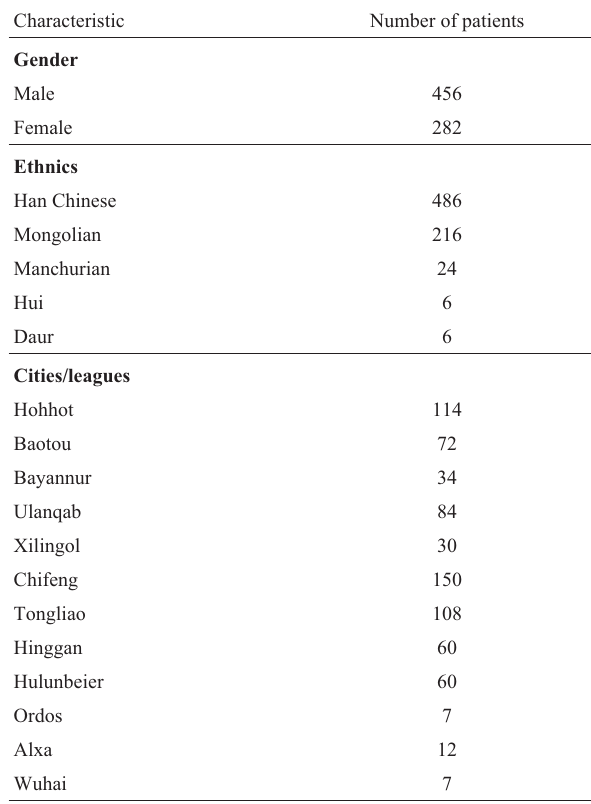
Table 1 - Characteristics of study